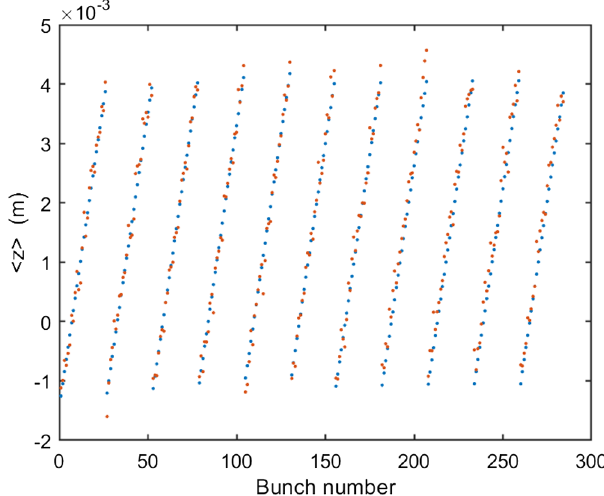
bunches.FIG. 16. ρ ð z Þ of the first bunch in a train of 26, by macroparticle simulation (red dots) and Haïssinski solution (blue